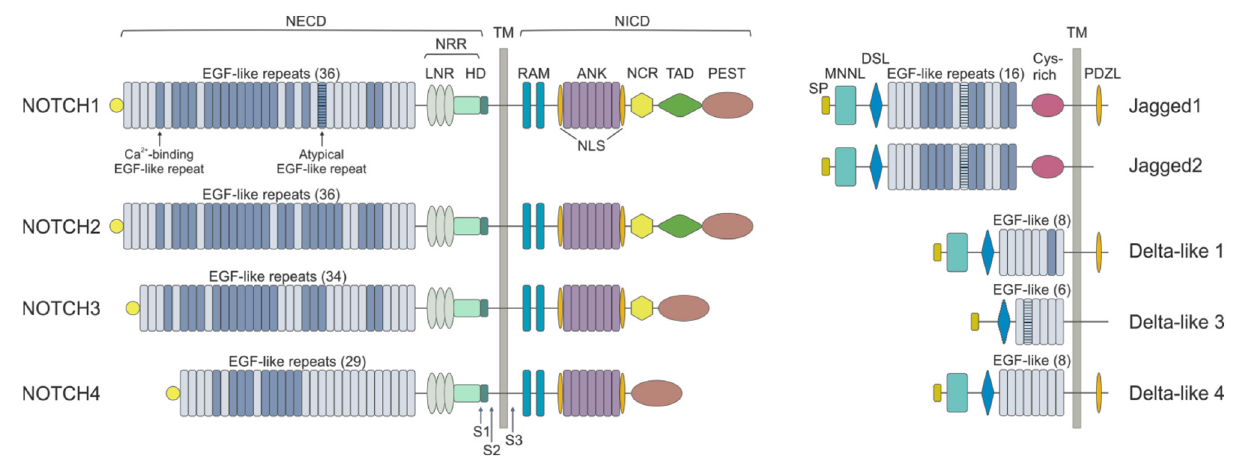
FIGURE 1 | NOTCH receptors and ligands. NOTCH receptors are structurally conserved type I proteins. There are four mammalian NOTCH receptors (NOTCH1-4) that contain multiple extracellular epidermal growth factor (EGF) repeats (from 29 to 36). Specific EGF repeats mediate ligand interactions. EGF repeats are followed by the negative regulatory region (NRR), which is composed of three cysteine-rich Lin repeats (LNR) and a heterodimerization domain (HD). NOTCH also contains a transmembrane domain (TM), an RBPJk associated module (RAM) domain, a nuclear localization sequences (NLS), a seven ankyrin repeats (ANK) domain, a NOTCH cytokine response (NCR) region, a transactivation domain (TAD) and a proline-glutamic acid-serine-threonin rich (PEST) domain. Mammalian NOTCH proteins are cleaved by furin-type convertases, which convert the NOTCH polypeptide into a NOTCH extracellular domain (NECD) and NOTCH intracellular domain (NICD) heterodimer that is connected by non-covalent interactions. After ligand binding, NOTCH is cleaved by metalloproteases and γ -secretase (S1, S2, and S3). NOTCH ligands can be divided into Jagged (Jagged 1 and Jagged 2) and Delta-like (DLL1, DLL3, and DLL4) groups on the basis of their domain composition. The extracellular domain of ligands is characterized by a NOTCH ligand N-terminal domain (MNNL), a Delta/Serrate/LAG-2 (DSL) domain, EGF motifs and a cysteine-rich (Cys) domain. DLLs lack this latter domain. The intracellular portion may contain a post-synaptic density protein ligand domain